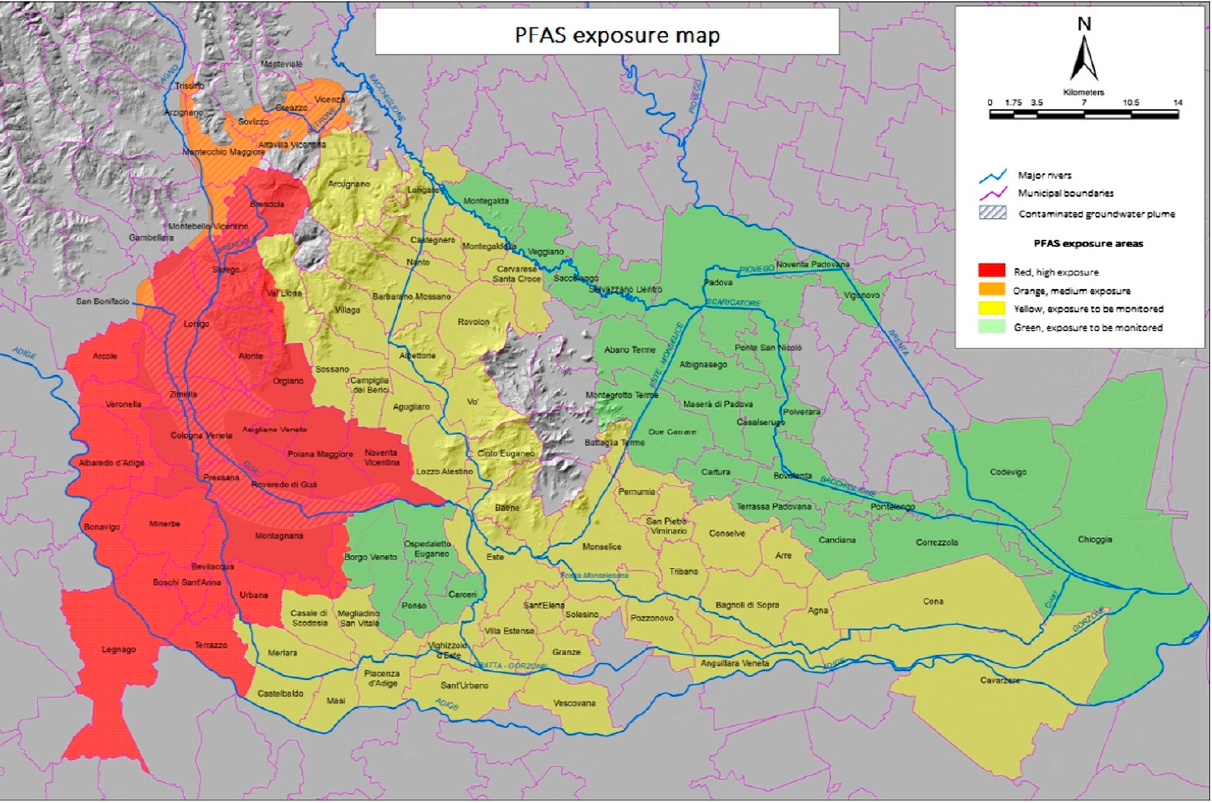
Figure 1. PFAS exposure map indicates the different colored areas and the Municipalities involved [62].